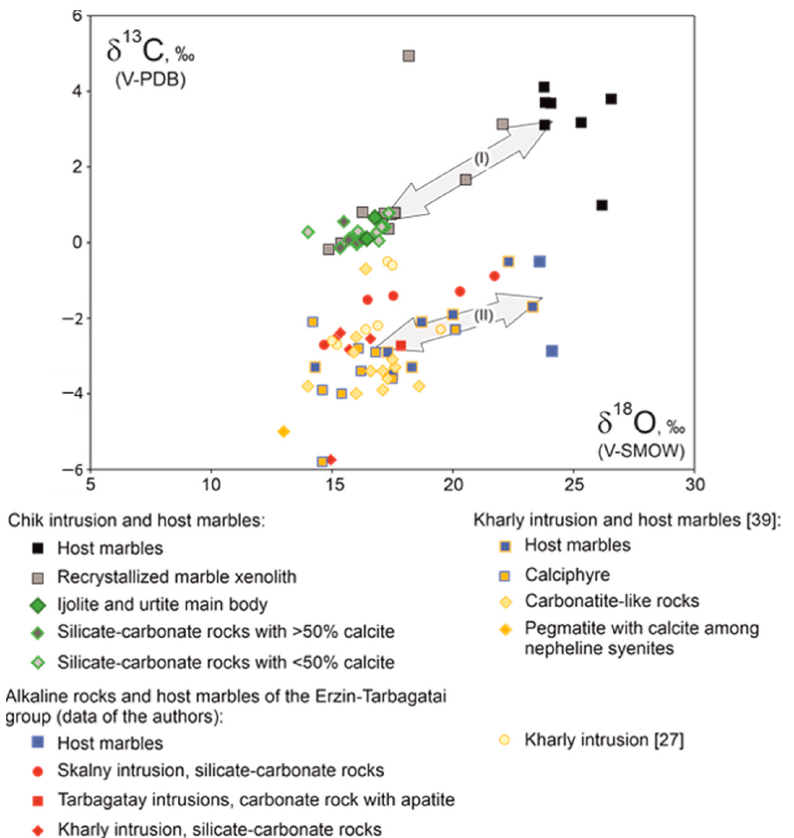
Figure 6. Isotope composition of the carbonate component of rocks of alkaline intrusions and host carbonate strata: (I) Chik intrusion, and (II) intrusions of the Erzin–Tarbagatay group.